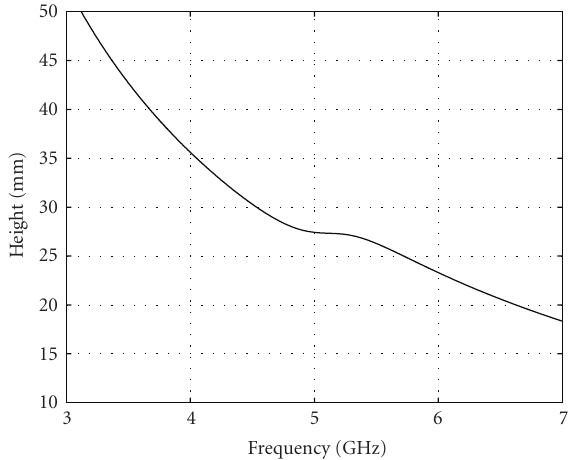
Figure 4: Height of the EBG